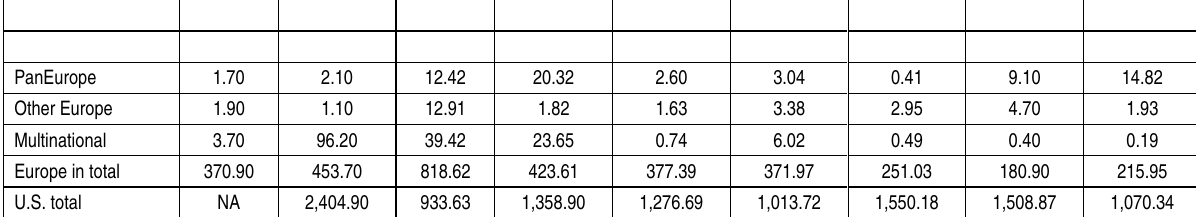
Table 5 (cont.). Distribution of asset securitization bonds by year: Europe versus US